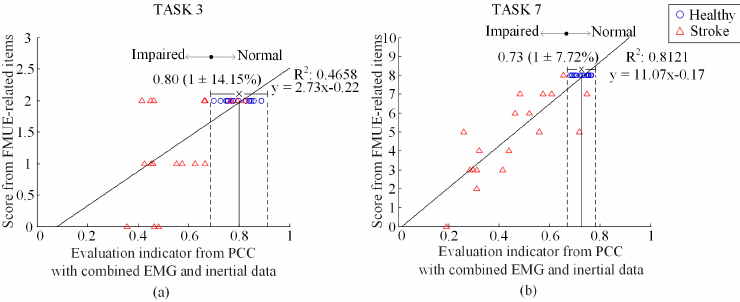
Figure 6. Plot of score of FMUE-related items versus the EI for TASK 3 ( a ) and TASK 7 ( b ). All symbols and lines appear in the same way as illustrated in Figure 5.